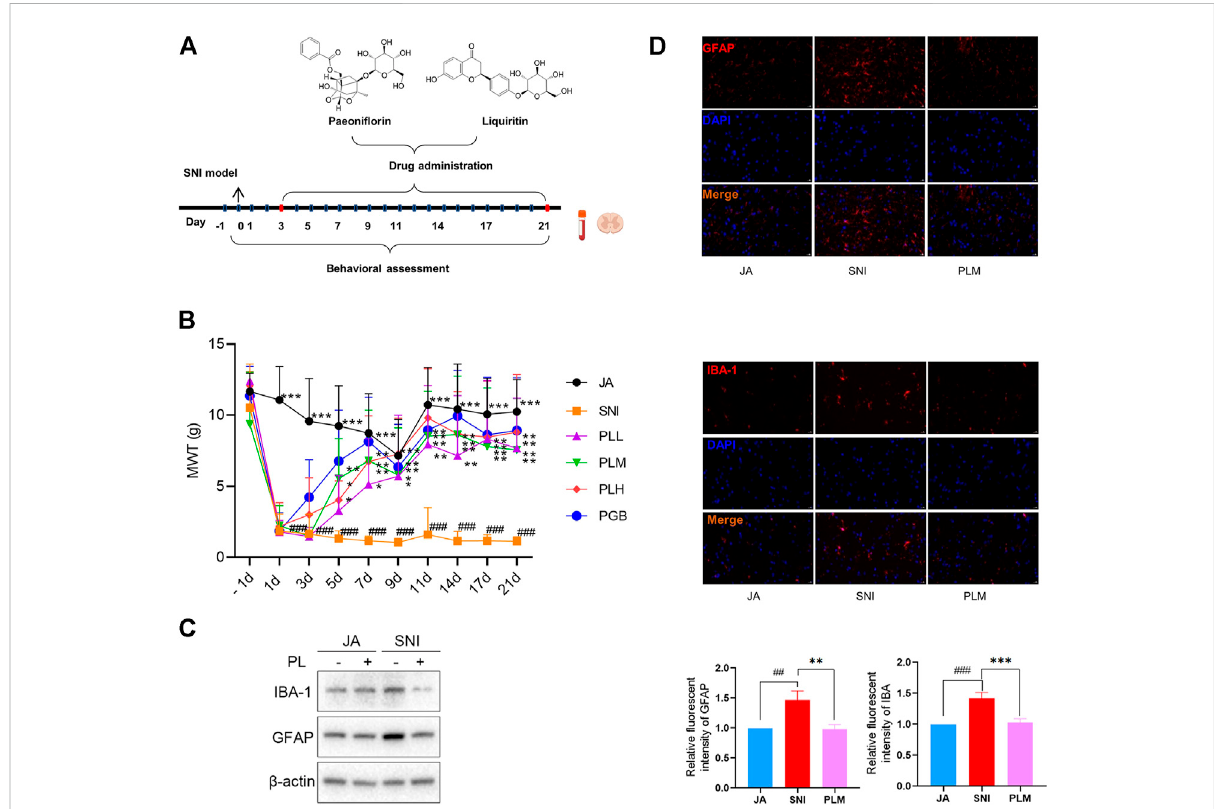
FIGURE 2 (A) Experimental roadmap of paeoni fl orin and liquiritin combination on SNI. (B) Mechanical withdrawal threshold (MWT)of each group. (C) The expression of GFAP and IBA-1 in JA, SNI, and PLM evaluated by Western blot. (D) The expression of GFAP and IBA-1 in JA, SNI, and PLM evaluated by immuno fl uorescence. JA, sham-operated group; SNI, spared nerve injury group; PLL, PLM, and PLL, low, middle, and high dose of paeoni fl orin and liquiritincombinationgroup;PGB,pregabalingroup.ComparedwithJA,## p < 0.01,### p < 0.001;comparedwithSNI,* p < 0.05,** p < 0.01, *** p < 0.001.